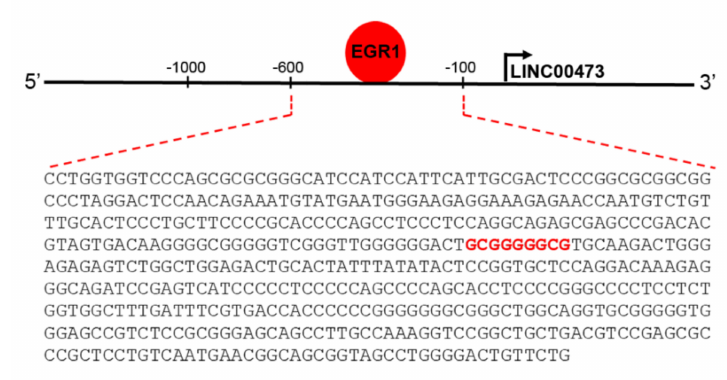
Figure 3. Schematic representation of LINC00473 promoter region showing the EGR1 binding site (GCGGGGGCG) at − 393 / − 385